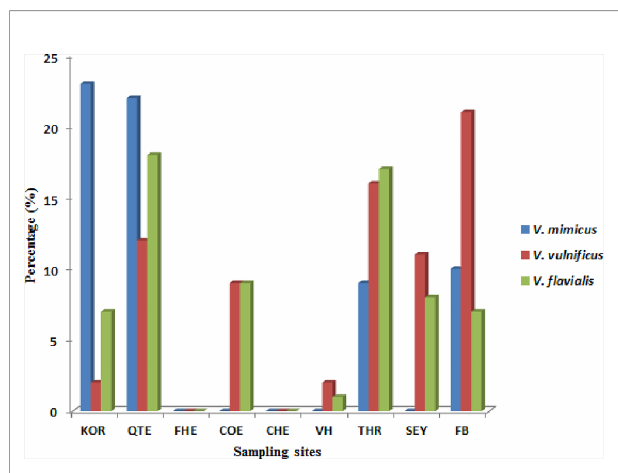
FIGURE 1 | Frequency of Vibrio species recovered from the different